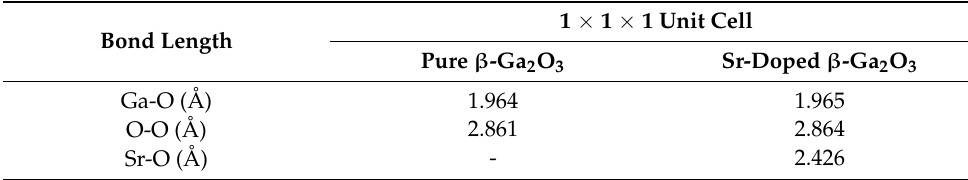
Table 3. Calculated average bond length of pure β -Ga 2 O 3 and Sr-doped β -Ga 2 O 3 for 1 × 1 × 1 unit cell.